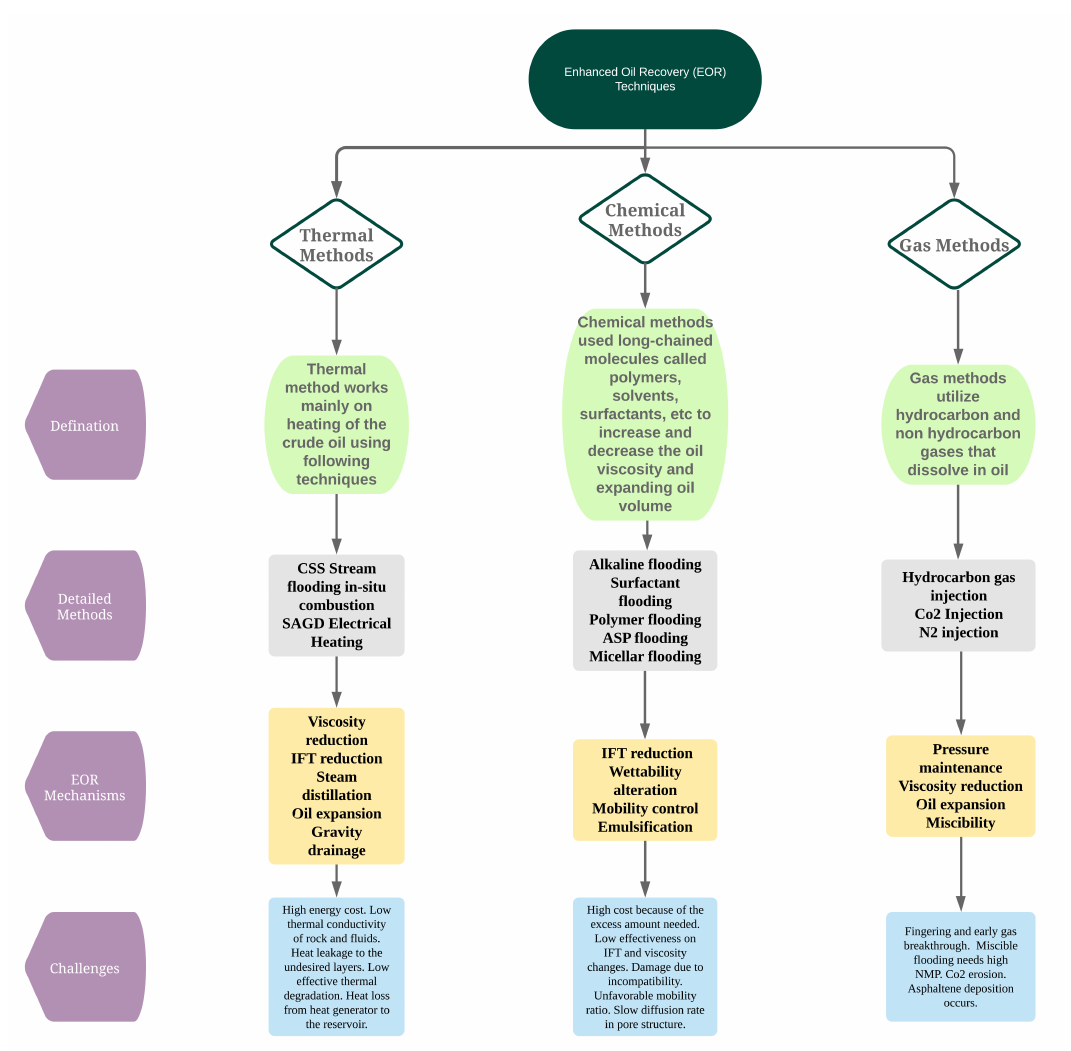
Figure 1. Different categories of Enhanced Oil Recovery (EOR) techniques